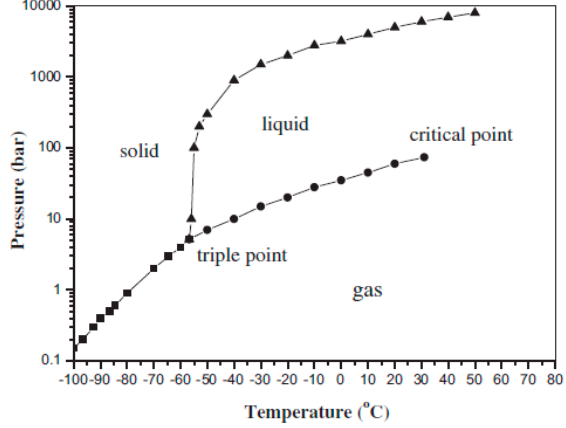
Figure 1. Three-phase diagram of CO 2 [8]